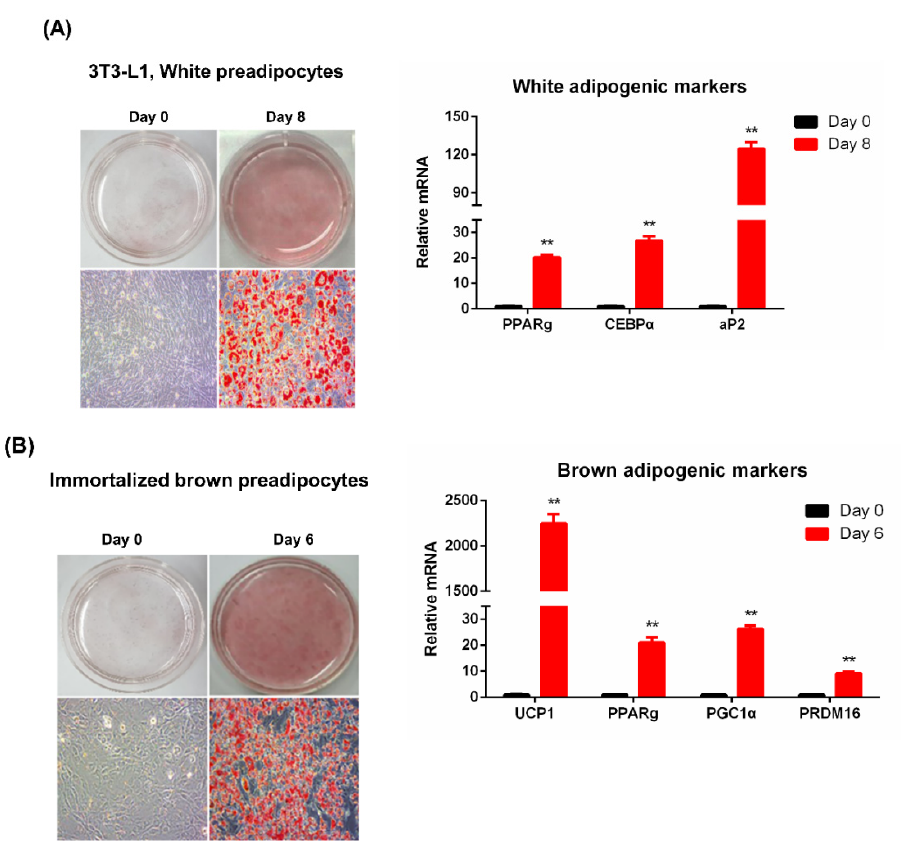
Figure 1. Characteristics of adipocytes assessed by Oil-Red-O and expression of adipocyte markers. ( A ) Expression of white adipocyte markers in white adipogenesis (white adipocyte differentiation) using RT-PCR analysis. ( B ) Expression of brown adipocyte markers in brown adipogenesis (brown adipocyte differentiation) using RT-PCR analysis. MWCM: mature white adipocyte conditioned medium; WPCM: white preadipocyte conditioned medium; WAM: white adipocyte medium; MBCM: mature brown adipocyte conditioned medium; BPCM: brown preadipocyte conditioned medium; BAM: brown adipocyte medium. ** p < 0.01.